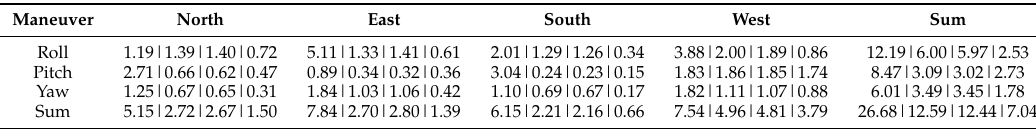
Table 5. The peak-to-peak values of uncompensated (UN), LS-compensated, RR-compensated, and MM-compensated signals (UN|LS|RR|MM).